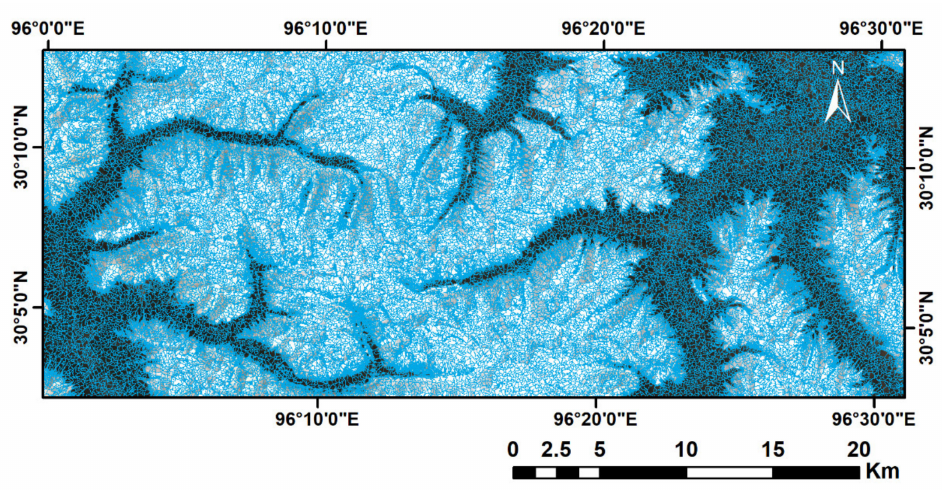
Figure 6. Segmentation results using quickshift. (Kernel size = 2, maximum distance = 8, and segmented objects are delineated in blue